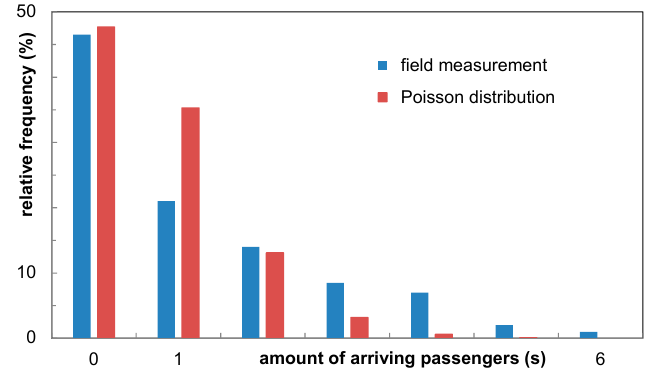
Figure 9. Expected amount arriving passengers in 5 s interval considering field measurement data and Poisson distribution ( λ = 0.74).